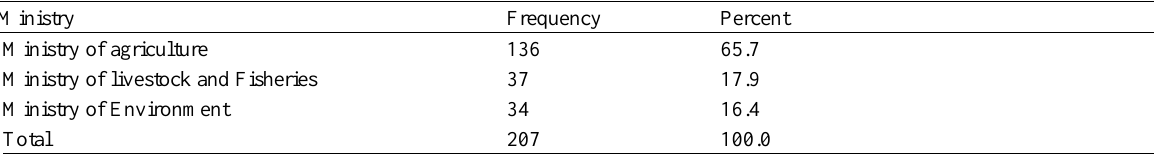
Table 3: Ministries helping CBOs implement